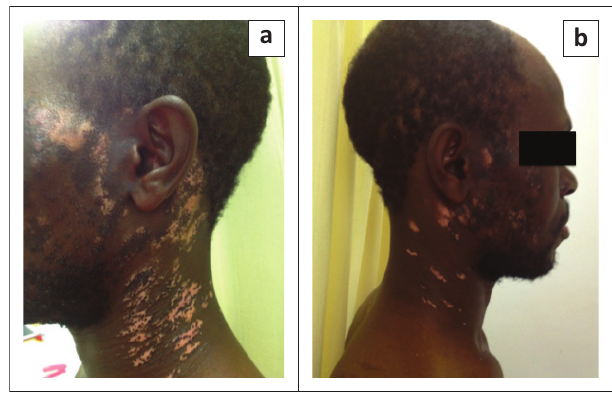
FIGURE 4: Actinic lichenoid leukomelanoderma (a and b) of HIV. FIGURE 5: Lichenoid